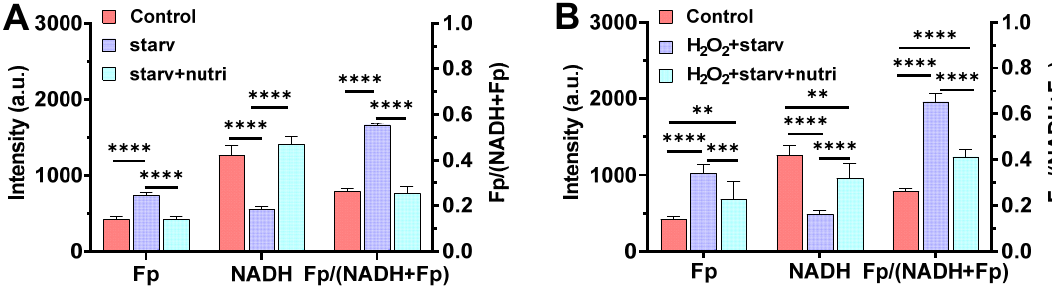
Figure 5. The effect of oxidative stress on the restoration of the NAD(H) redox status of mouse alveolar macrophage cell line MH-S (mean ± SD). ( A ) The NAD(H) redox status was fully restored upon replenishing with glucose and glutamine when AM had no prior oxidative insult before nutrient starvation ( n = 4), where “starv” = AM in nutrient-free medium at 2 °C for 2.5 h; “starv + nutri” = cells replenished with 11 mM glucose + 2 mM glutamine after “starv”. The results simulate the case of FA exposure (i.e., Figure 4A–C). ( B ) The NAD(H) redox status was only partially restored by replenishing with 11 mM glucose + 2 mM glutamine when AM were first incubated with 135 µM H 2 O 2 for 30 min at 37 °C prior to nutrient starvation, despite that the added H 2 O 2 was rinsed off before nutrient starvation ( n = 5–8). “H 2 O 2 + starv” = 135 µM H 2 O 2 -pretreated AM underwent nutrient starvation at 2 °C for 2.5 h without the presence of exogenous H 2 O 2 ; “starv + nutri” = cells replenished with 11 mM glucose + 2 mM glutamine after “H 2 O 2 + starv”. The results simulate the case of O 3 exposure (i.e., Figure 4D–F). ** p < 0.01, *** p < 0.001, and **** p < 0.0001.